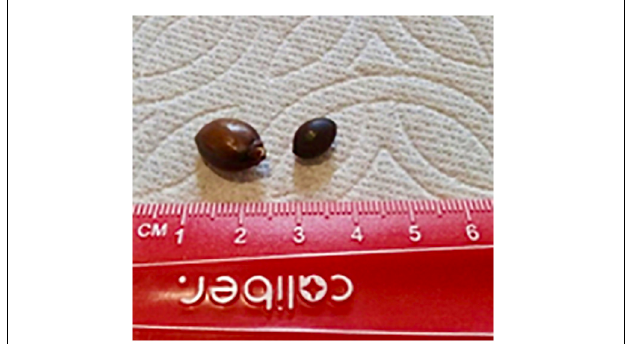
FIGURE 4 | Seeds of P . microphylla post-gut transit and recovered from feces of a rattlesnake ( C. atrox ) in the primary study. The seed on the left has undergone imbibition (imbibed and swelled) and germinated (presence of the radicle) while the other seed shows no outward change in appearance from its original state despite having been exposed to the digestive tract.